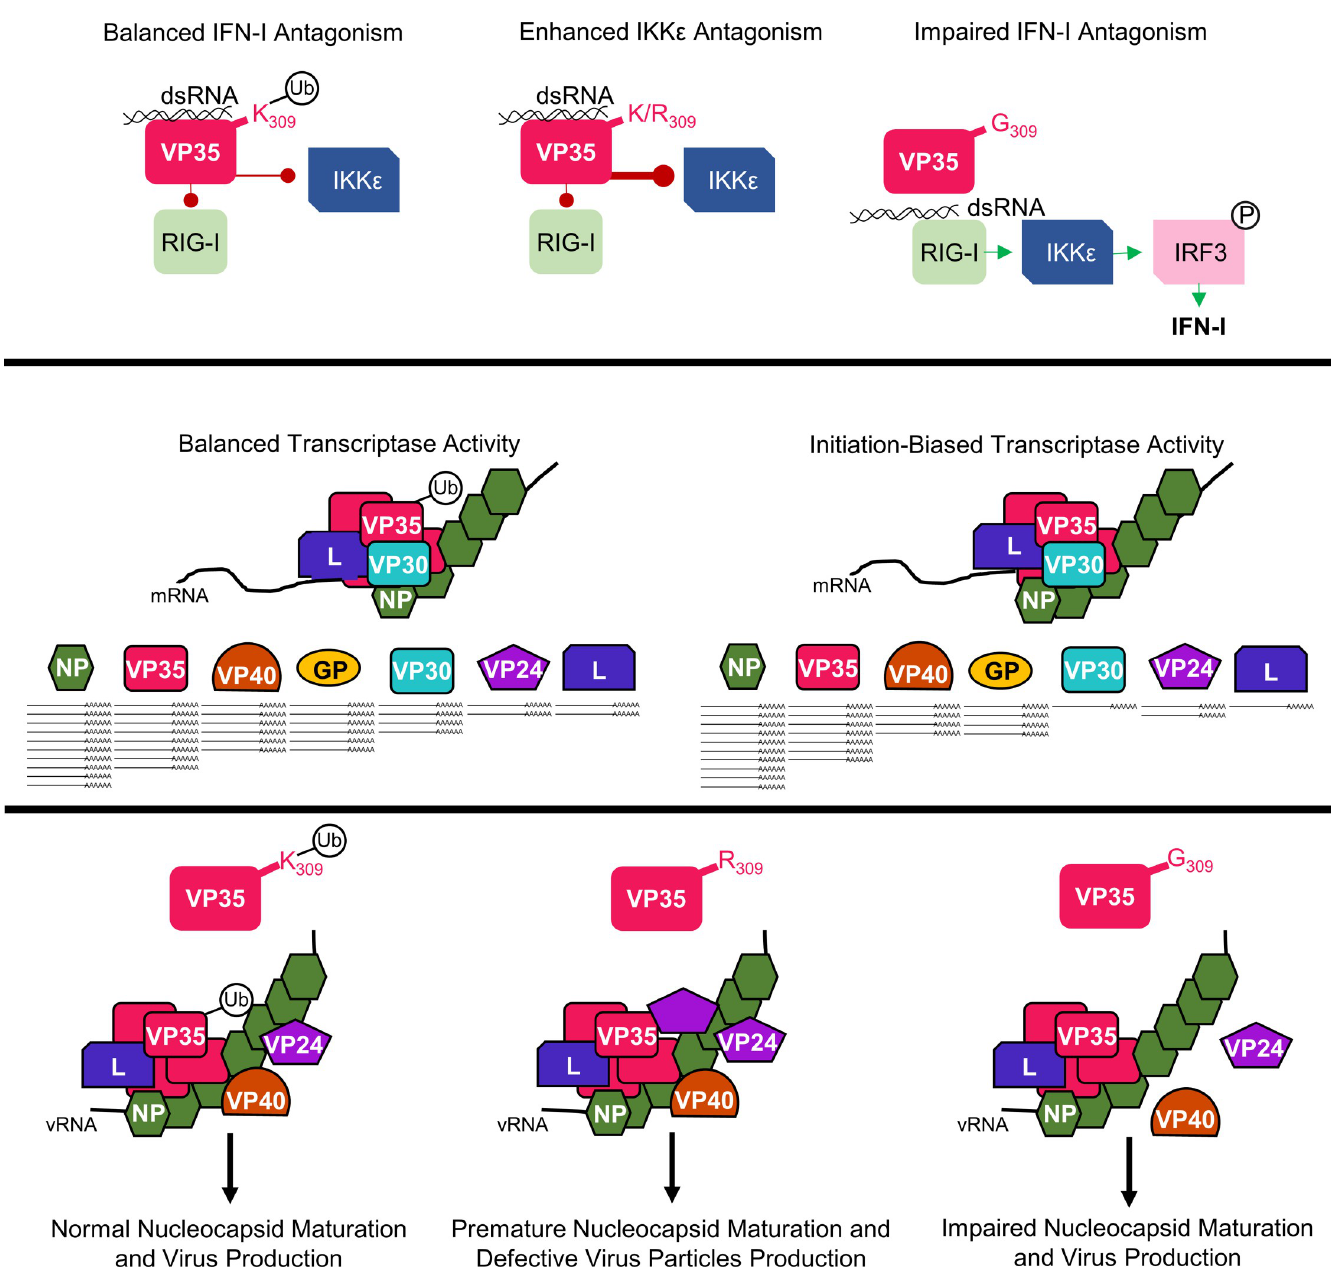
Fig 9. A basic residue and the ubiquitination capacity of VP35/309 coordinates VP35’s functions. Both ubiquitinated (white circle with Ub) and non-ubiquitinated (K/R 309 ) VP35 bind double-stranded RNA (dsRNA) to antagonize RIG-I. Loss of a basic residue (G 309 ) impairs dsRNA binding which allows RIG-I activation and downstream IRF3 phosphorylation (white circle with P) leading to type I interferon (IFN-I) induction. In the absence of ubiquitination, VP35 (K/R 309 ) impedes IKK